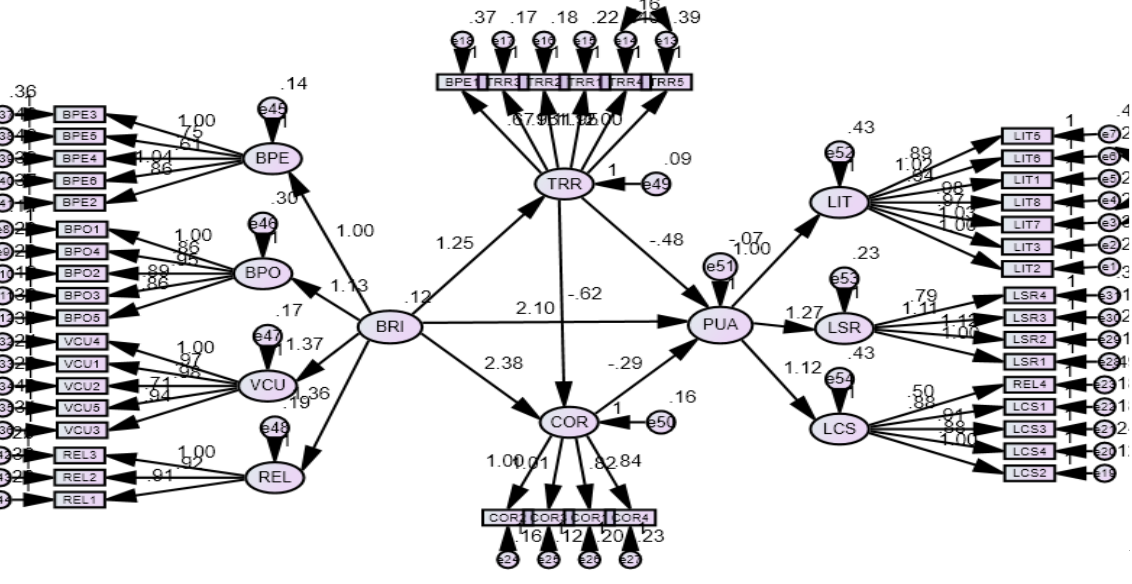
Figure 3. SEM model analysis